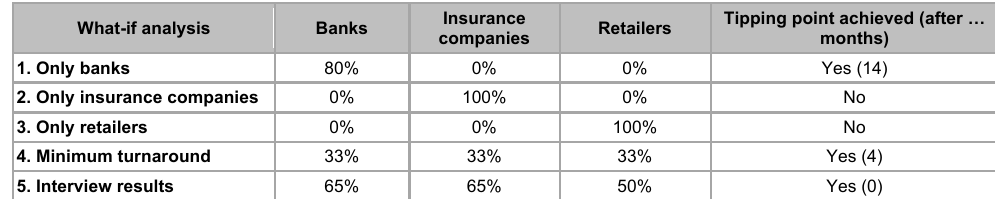
Summary results from what-if